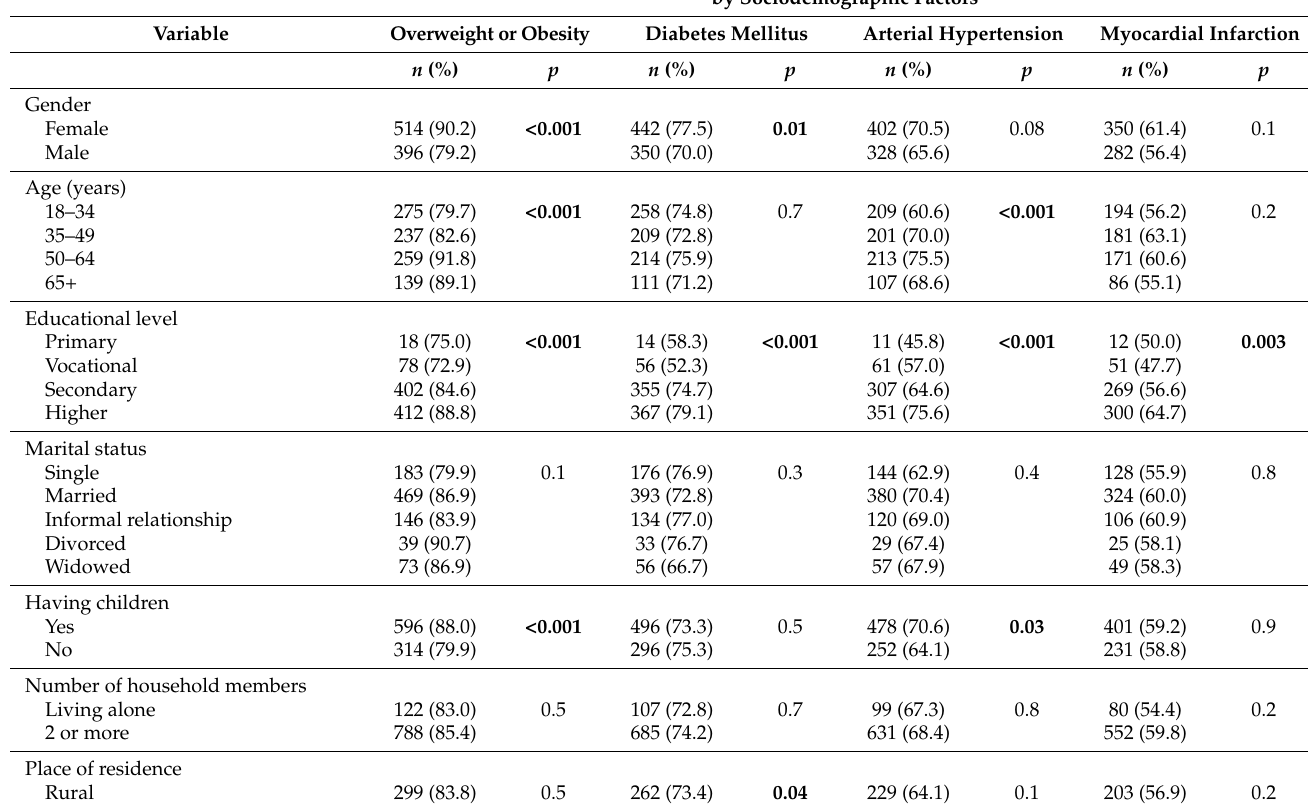
Table 3. Awareness of diet-related diseases by sociodemographic factors ( n = 1070). Diet-Related Diseases—Percentage of Respondents Who Answered “Yes” by Sociodemographic